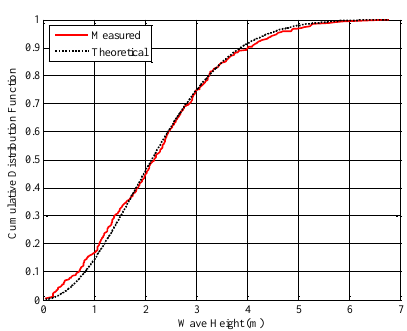
Figure 12. Wave heights derived from the LiDAR surface points.